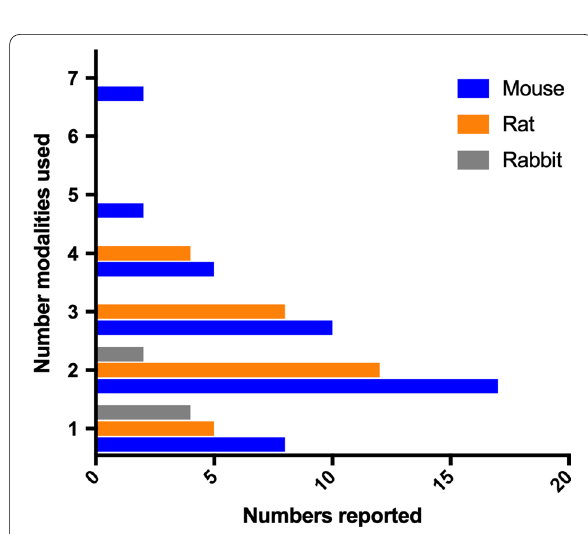
Fig. 7 Number of read‑outs used per study in preclinical inflammatory musculoskeletal